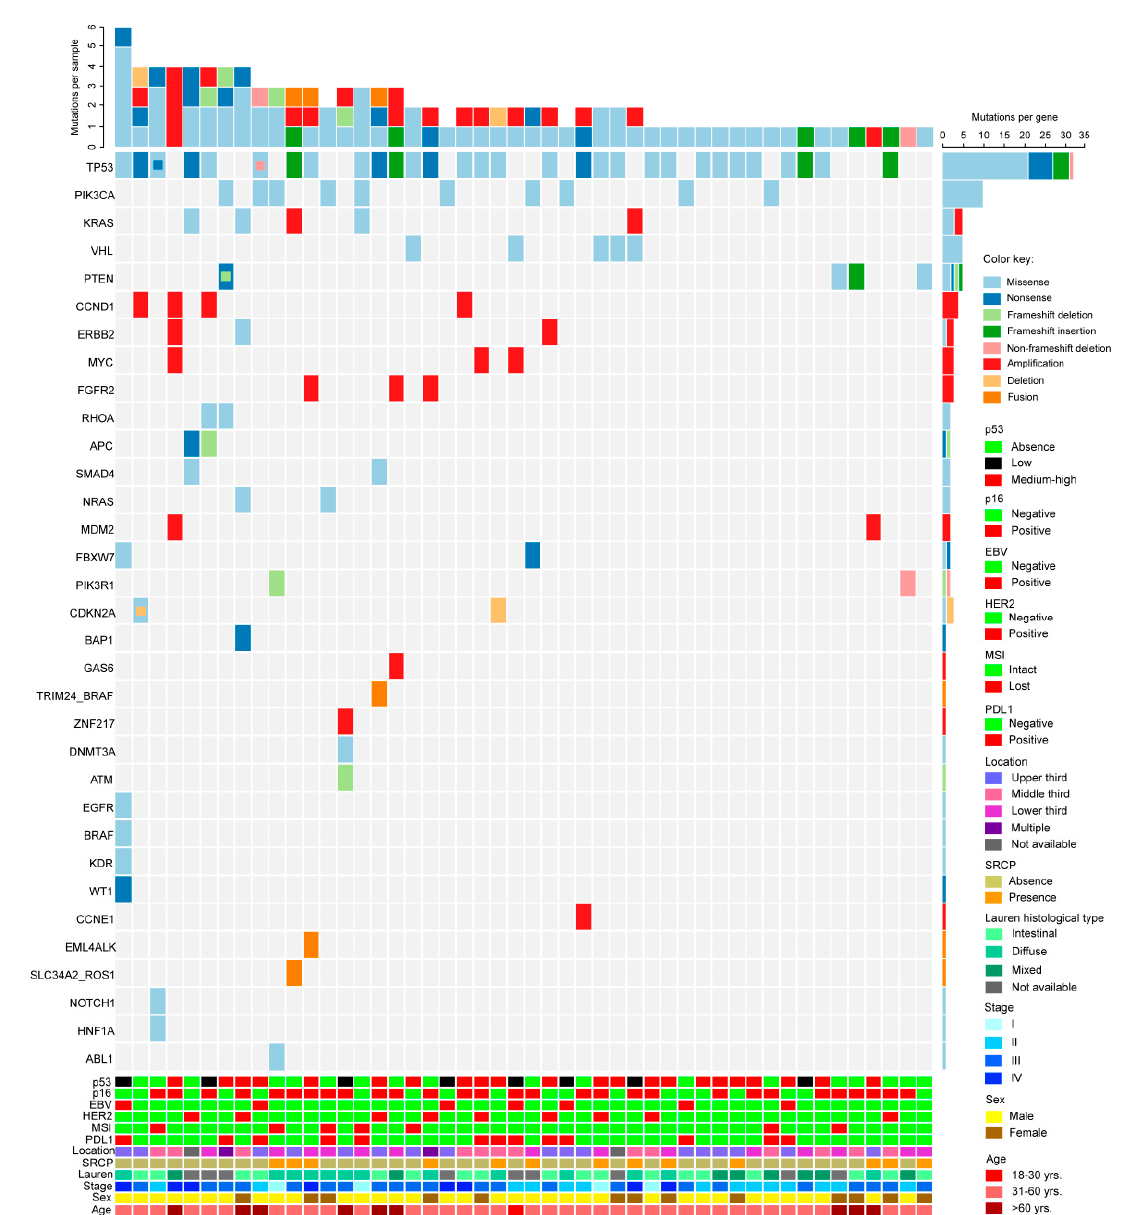
Figure 2. Profiling of 48 Chilean gastric cancers by next generation sequencing (NGS), clinical, and pathological characteristics. The waterfall plot shows the number of gene alterations per patient (upper section), number of alterations per gene (right). Colored squares indicate the alteration type (SNV, CNV, or fusion drivers / see key). Clinical (age, gender, Lauren classification, signet ring, tumor location), and pathological (PDL1, MSI, HER2, p16, p53, EBV) characteristics for each patient are shown in the lower section.